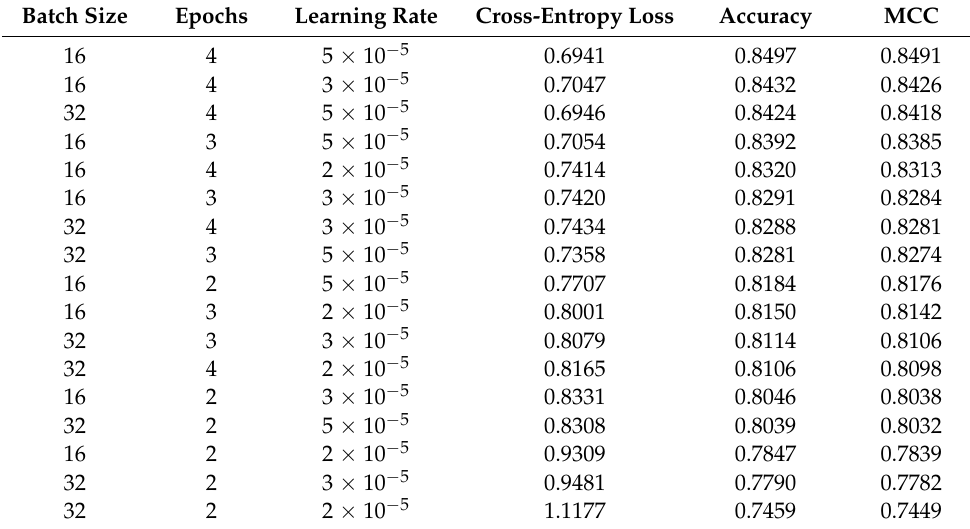
Table 4. Portuguese BERT results for Chapter 90.